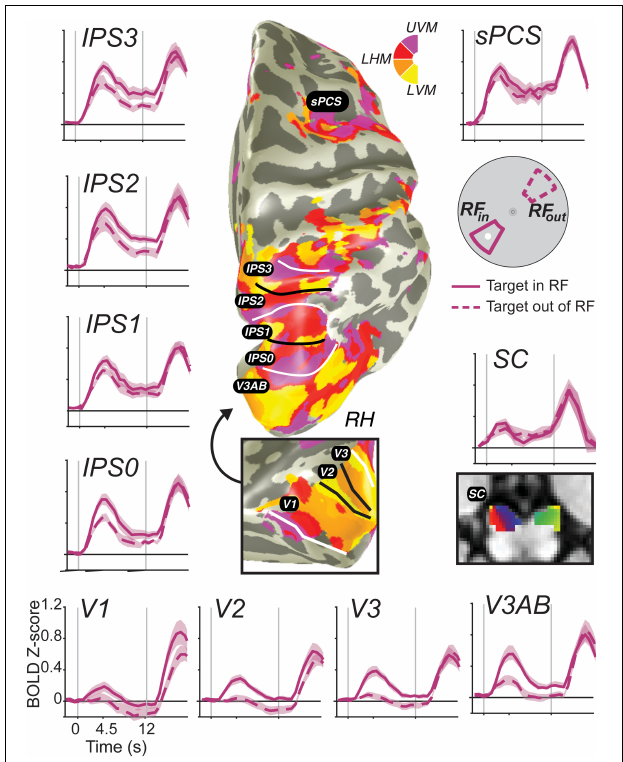
FIGURE 3 | Stimulus-selective persistent activity across the human brain measured with fMRI. BOLD activity persists during the retention interval of memory-guided saccade tasks in many cortical and subcortical brain areas (Hallenbeck et al., in press). Each region-of-interest was defined using modified pRF mapping procedures (Mackey et al., 2017; Rahmati et al., 2020). Solid lines are the average BOLD signal from trials in which the memory target fell within the pRF of voxels. Dashed lines represent the averaged signal from trials in which the target was 180 ◦ away from the target. Error bands are SEM. Gray vertical lines represent the onset of a brief visual target and the end of the retention interval. Notice how the general amplitude of persistent activity increases from early visual cortex to parietal cortex to frontal cortex, but the spatial selectivity generally decreases. Moreover, BOLD activity persists in retinotopically organized human superior colliculus (SC) (Mackey et al., 2017; Rahmati et al.,